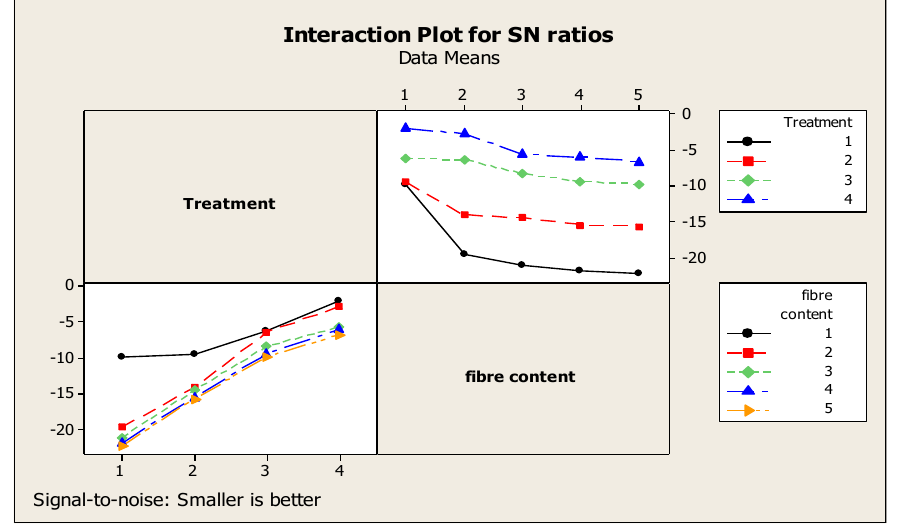
Fig. 7. Interaction for signal-to-noise ratio of treatment and fibre content on percentage of water